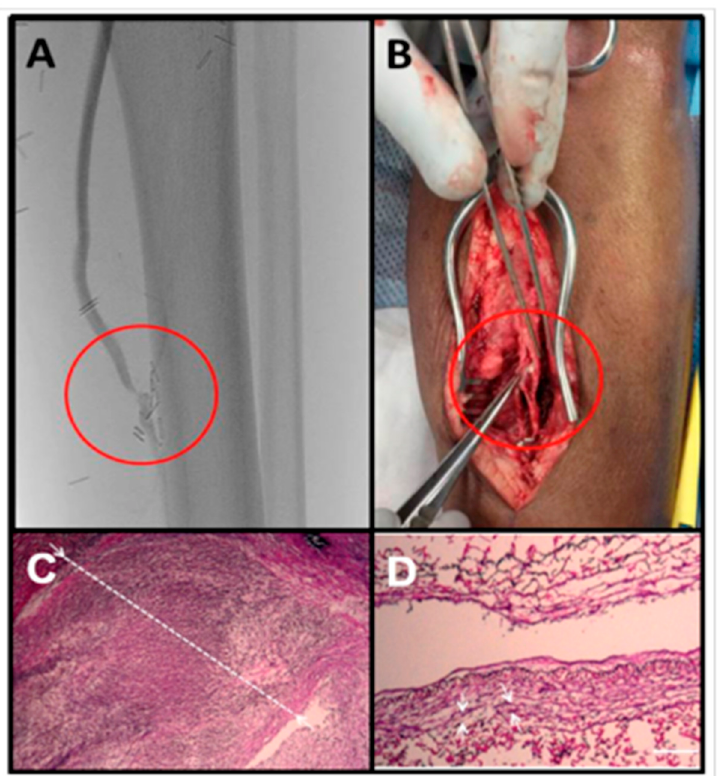
Figure 1. Intimal hyperplasia of a vein graft at the distal anastomosis. This bypass graft was failing based on surveillance duplex ultrasound examination. ( A ) Arteriogram confirmed a stenosis at the distal anastomosis. ( B ) This patient ultimately had an open surgical revision of this anastomosis. ( C ) Pathology demonstrated a dense cellular lesion with a greatly thickened intima (white line) and a nearly obliterated lumen. ( D ) An adjacent segment of relatively normal appearing vein graft is presented for comparison (Scale bar = 100 μ m).